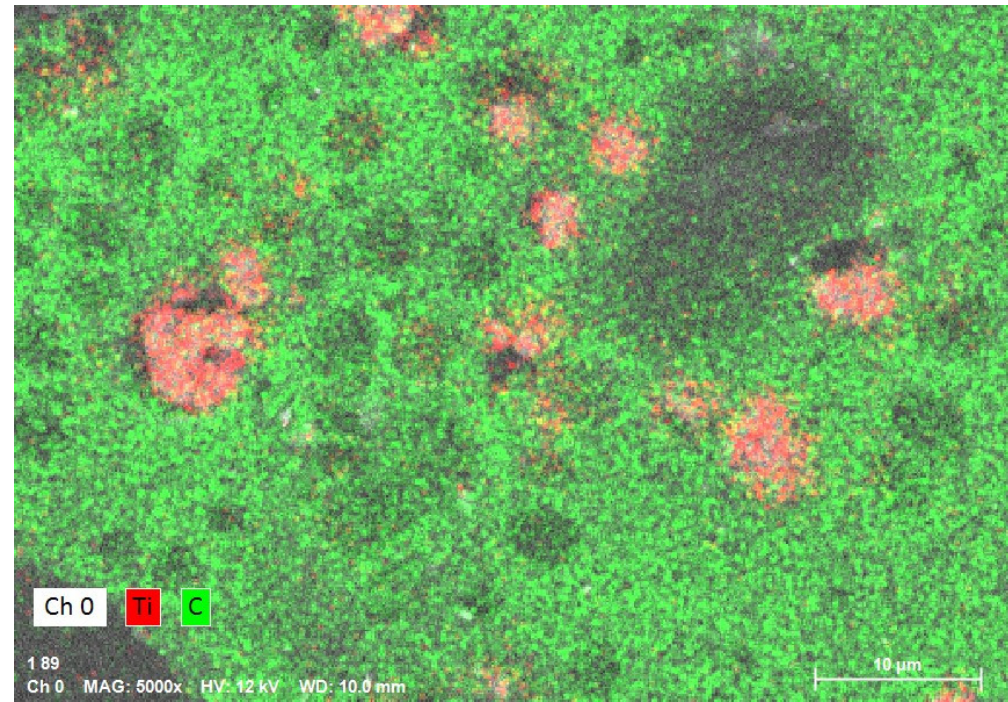
Figure 9. Element map of the nanocomposite for Ti (TiO 2 NPs Cp = 1 wt%) using EDS on SEM (nanocomposite manufactured with the sonication process).